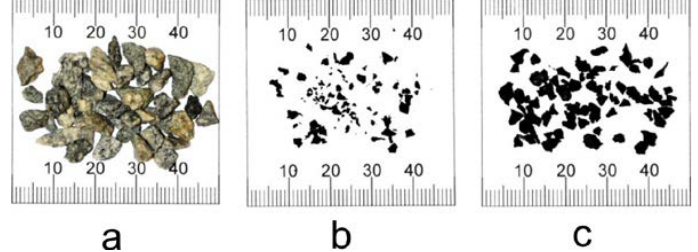
Figure 1. Mineral and crumb rubber materials used in the tests: ( a ) gneiss coarse aggregate 2/5; ( b ) crumb rubber 0.5/2; ( c ) crumb rubber 1/4. ( b ) crumb rubber 0.5 / 2; ( c ) crumb rubber 1 / 4.